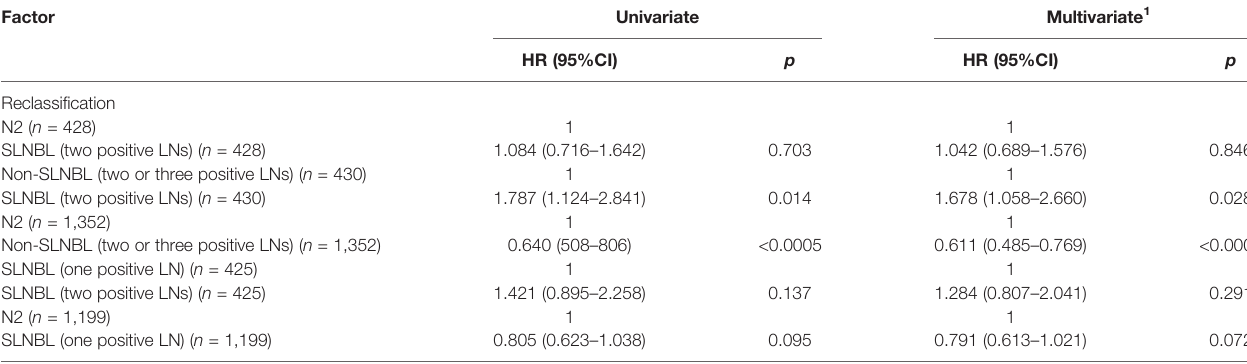
TABLE 2 | Prognostic factor of nodal burden according to lymph nodes analyzed after propensity score matching (PSM). Factor